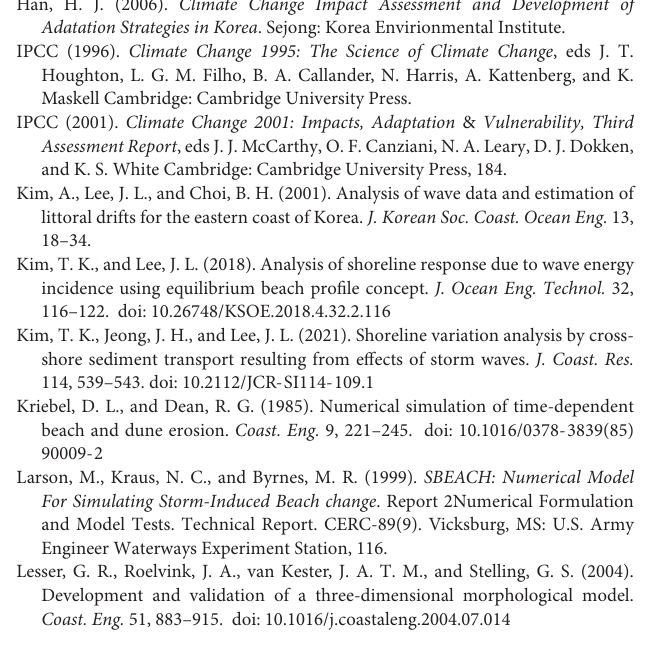
Supplementary Figure 9 | Wave scenario models of wave height for Maengbang Beach; (A) 4.5 m ≤ H o p < 5.5 m, (B) 5.5 m ≤ H o p < 6.5 m, (C) 6.5 m ≤ H o p , and (D) comparison with respect to peak wave heights. Supplementary Figure 10 | Wave scenario models of wave period for Maengbang Beach; (A) 4.5 m ≤ H o p < 5.5 m , (B) 5.5 m ≤ H o p < 6.5 m , (C) 6.5 m ≤ H o p , and (D) comparison with respect to peak wave period. Supplementary Figure 11 | Probability histogram and 30-yr confidence level per zone at Maengbang Beach obtained from shoreline data; (A) Zone 1, (B) Zone 2, (C) Zone 3, and (D) Zone 4. Supplementary Figure 12 | Result of Chi-squared goodness of fit test at Maengbang Beach obtained from shoreline data. Supplementary Figure 13 | Extreme distribution function between the return period (yr) and extreme breaking wave height H F ( m ) obtained from the NOAA data. Supplementary Figure 14 | Comparison between the erosion width obtained from BVC and monitored erosion width in the study site (A) 10-year return period, and (B) 30-year return period. Supplementary Figure 15 | Beach profiles estimated from BVC plotted on the three dimensional LiDAR image. Supplementary Table 1 | Median grain size D 50 beach scale factor A and beach response factor a r for each survey zone at Maengbang Beach. Supplementary Table 2 | Monitored erosion width (MEW) (negative value; -m unit) with respect to return period. Supplementary Table 3 | Correlations between the return period and extreme breaking wave height H F . Supplementary Table 4 | Monitored erosion width (MEW) for 4 zones according to the breaking wave height H F . Supplementary Table 5 | The τ values for deep water wave heights H o p for 4 different k r values. Supplementary Table 6 | The µ values for each deep water wave heights H o p for 4 different k r